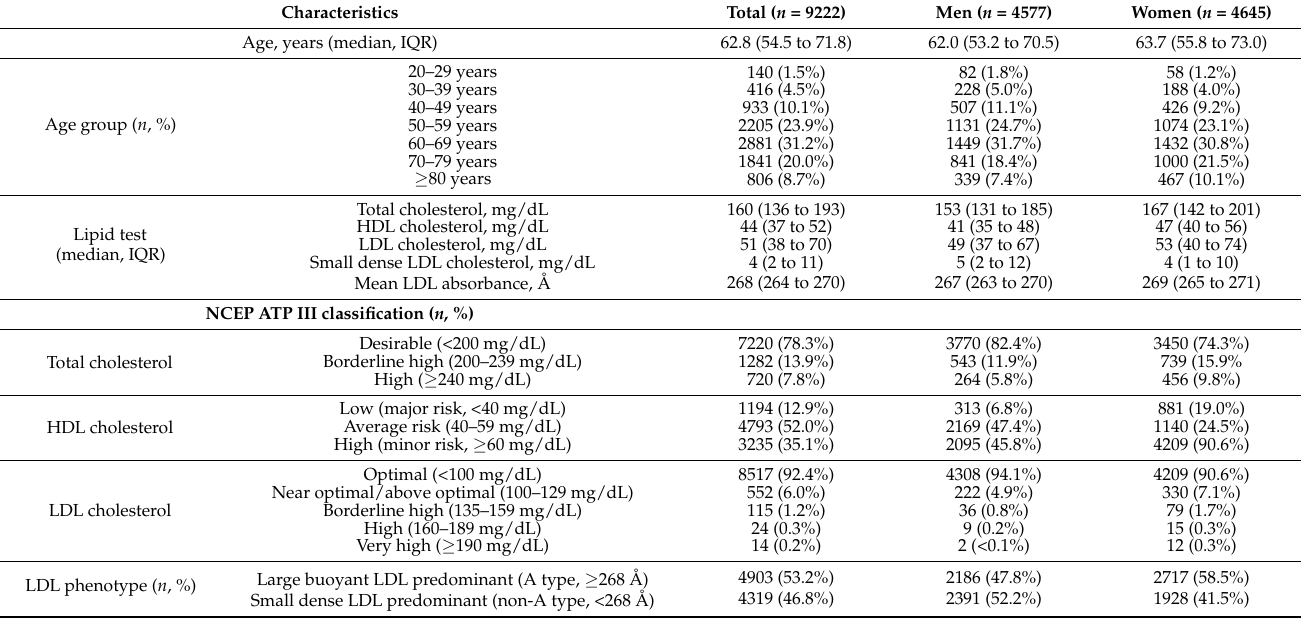
Table 1. Baseline characteristics of the